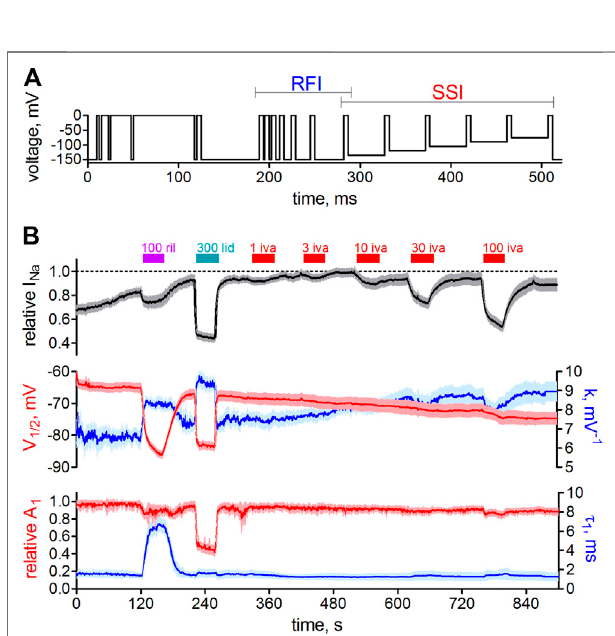
FIGURE 3 | Automated patch-clamp analysis of the effect of ivabradine on human Na v 1.5 fast inactivation. (A) Voltage-clamp protocol to simultaneously test for recovery from inactivation (RFI, blue bracket) and voltage-dependence of steady-state inactivation (SSI, red bracket) continuously once per second throughout the experiment. (B) Top: sodium current amplitude from hNa v 1.5 channels stably expressed in HEK-293 cells. Mean current trace ± SD from n = 11 recording channels, with each channel recording the average of a maximum of 20 cells. Perfusion of different drugs is indicated by the above bars; 100 µM riluzole (100 ril), 300 µM lidocaine (300 lid), and increasing concentrations of ivabradine (1 – 100 μ M; 1-100 iva). Middle: the parameters from automated fi tting of the SSI plot at 1 s time resolution. Half point of voltage-dependent inactivation (V 1/2 ; left axis, red) and steepness of respective voltage-dependence (k; right axis, blue). Bottom: Selected parameters from automated fi tting of the RFI plot. Recovery was fi t with a double-exponential function with the second, slow time constant constrained to 150 ms (see Methods). Relative amplitude of the fast time constant of recovery (A1; left axis, red) and respective fast time constant ( τ 1; right axis, blue). Time axis applies to all panels in B